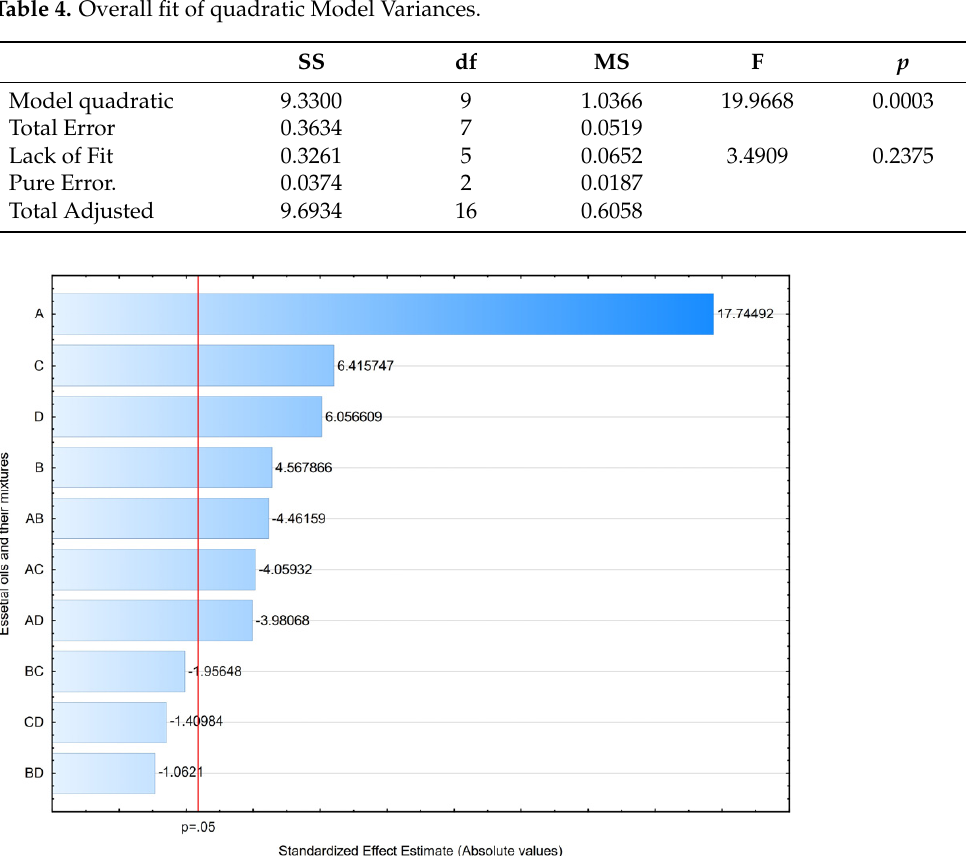
Figure 2. Pareto chart for a quadratic model with the normalized effects of the four experimental factors, in decreasing order of importance (in absolute terms) for the antioxidant activity (EC 50 ) response. Essential oil: cedarwood (A), citronella (B), thyme (C), basil (D).